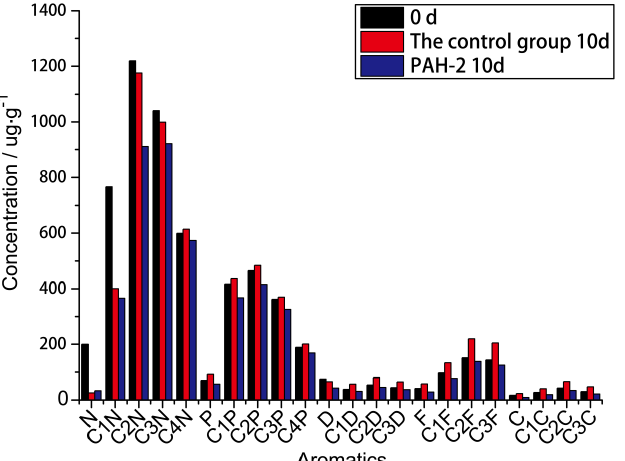
Figure 6. The degradation effect of PAH degrading bacillus PAH-2 in aromatic components across 10 days through GS-MS data.